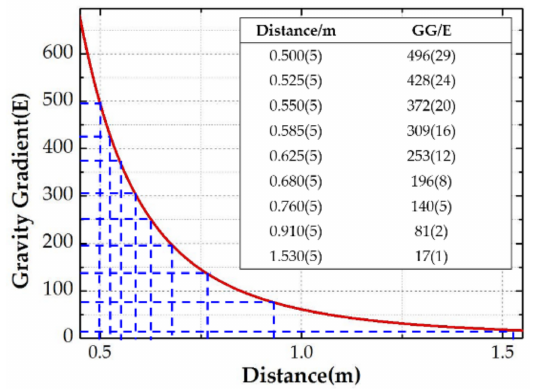
Figure 4. Theoretical calculation curve of gravity gradient.